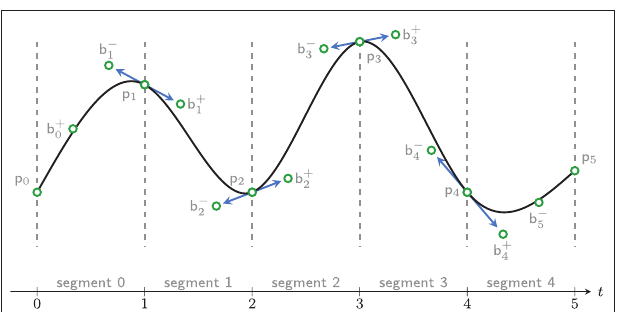
FIGURE 1 | Schematic representation of the composite cubic Bézier curve R (black), and its control points (green circles). M , for M B : [0,5] → = Continuous differentiability is reached at the junction of the segments (the blue arrows draw the first derivative of B